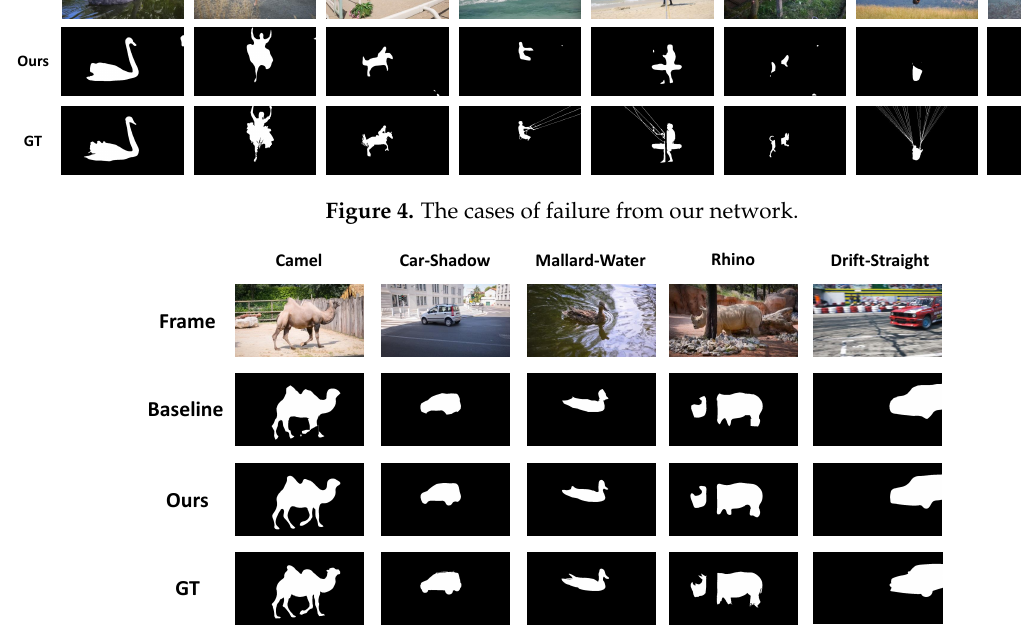
Figure 5. The examples of the segmentation results from our baseline and